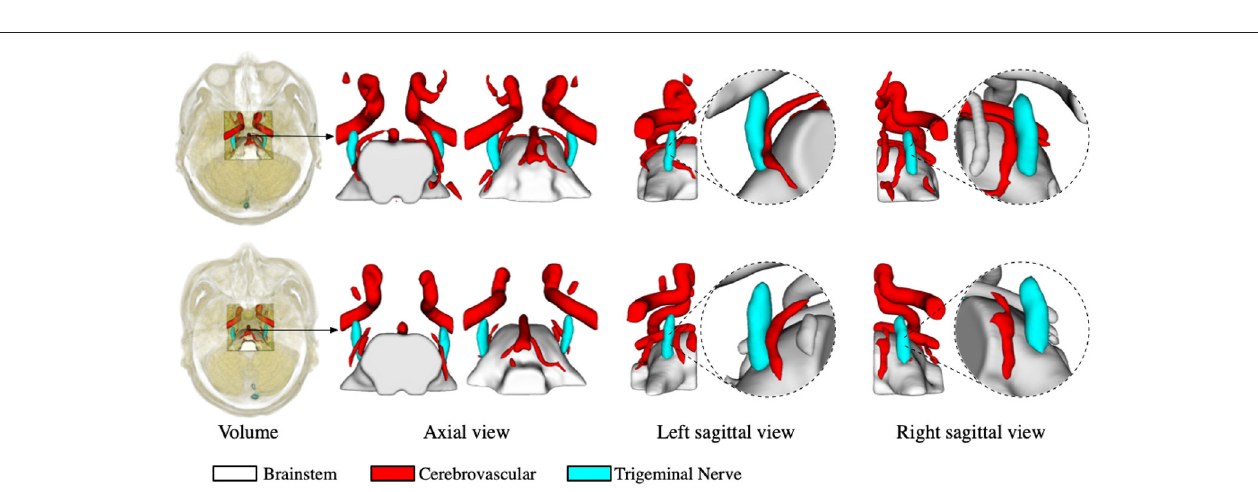
FIGURE 4 | Virtual visualization of the root entry zone for TN patients. The two rows show patients with bilateral trigeminal neuralgia, and left-sided trigeminal neuralgia, respectively. The first column shows the location of the cropped volume in the original MRA, as well as the predicted anatomy of the cerebrovascular and trigeminal nerve. The second and third columns illustrate the rendering of the predicted anatomical structures in the axial view, while the last four columns indicate the rendering of the left and right perspectives in the sagittal plane and their enlarged renderings, respectively.